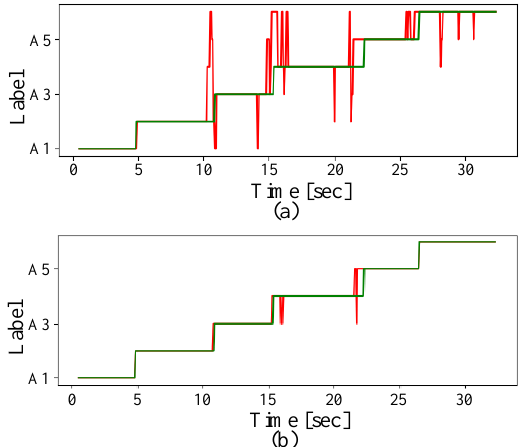
Figure 18. Comparison of ( a ) single-frequency Bi-LSTM prediction label and ( b ) parallelism Bi-LSTM with multi-frequency prediction label.